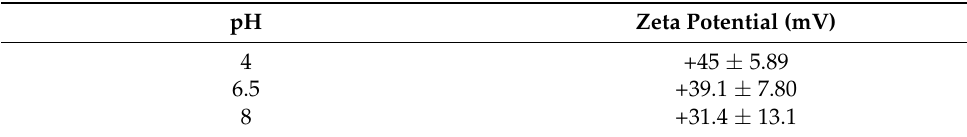
Table 5. Measurements of potential zeta for CBX-MG-PEI at different pH.